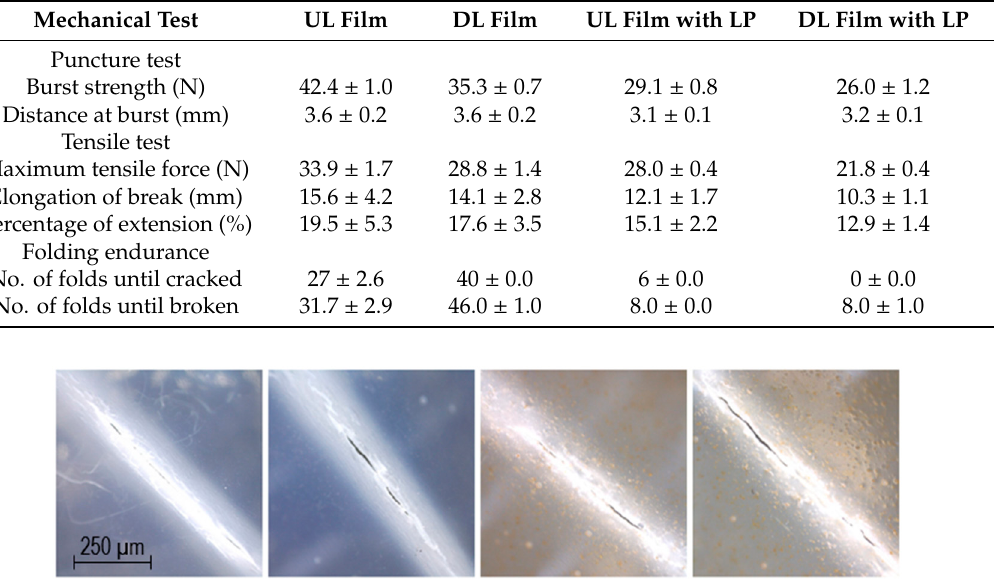
Figure 6. Pictures taken with a handheld digital microscope of cracks retained during the folding endurance test. From the left: unloaded film, drug-loaded film, unloaded film with liver powder, and drug-loaded film with liver powder.